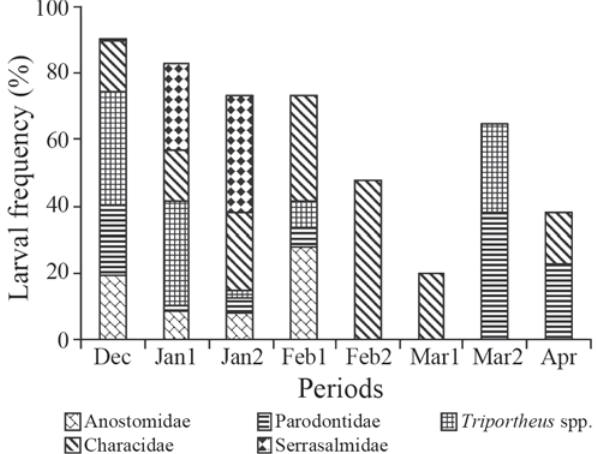
observed during the samplings (Table 1). A higher density of